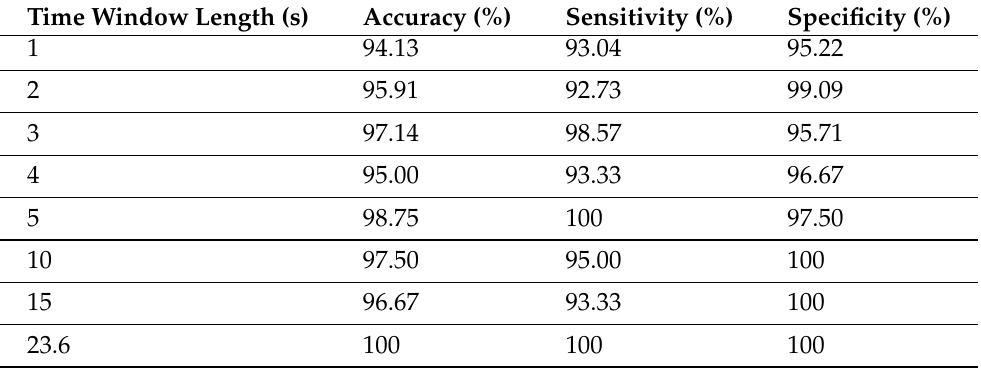
Table 4. The results of Experiment 1.